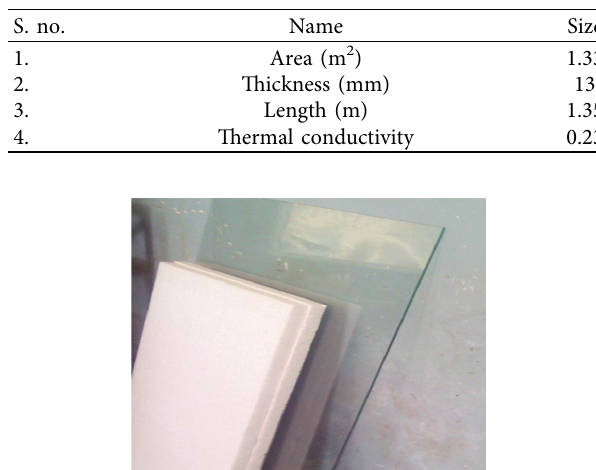
Table 1: Wooden box size and material.